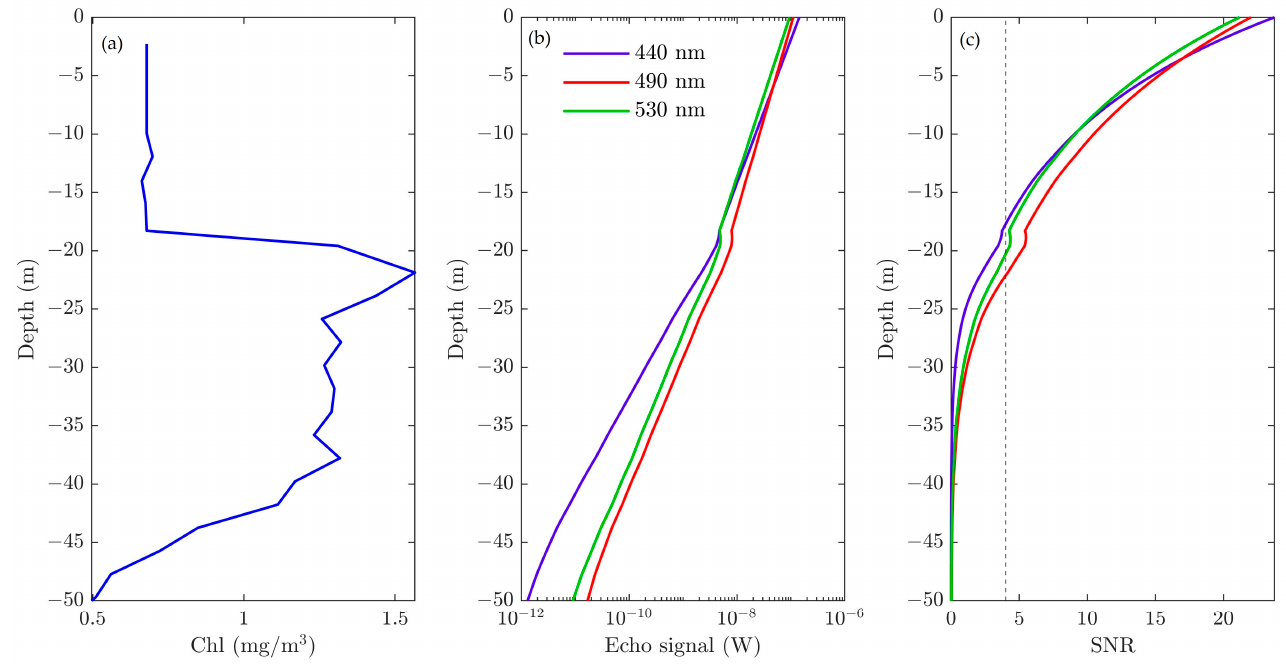
Figure 9. Simulation with stratified water. ( a ) The chlorophyll concentration profile measured by biogeochemical Argo; ( b ) simulated echo signal; ( c ) SNR, the gray dashed line represents SNR of 4.